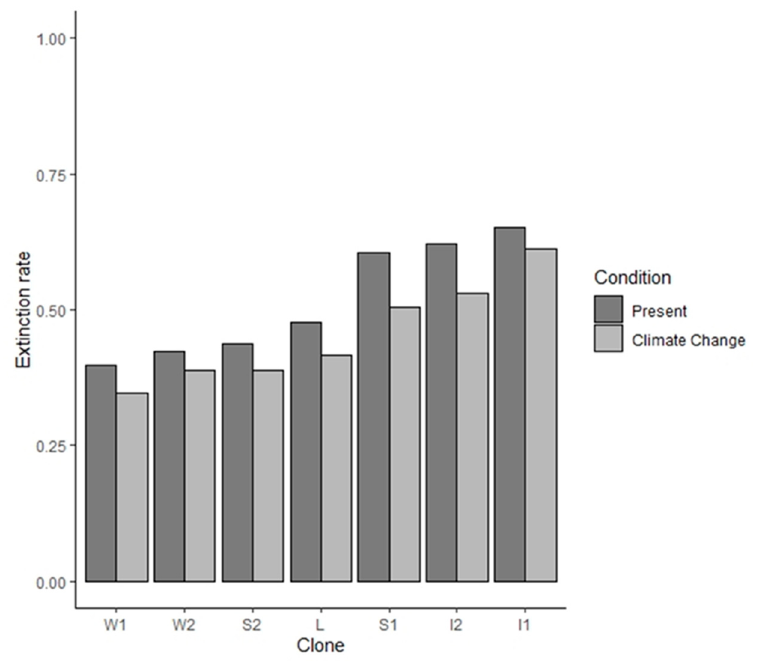
Figure 2. Extinction rates obtained by uncertainty analysis for each clone in present (dark grey) and climate change (light grey) conditions.